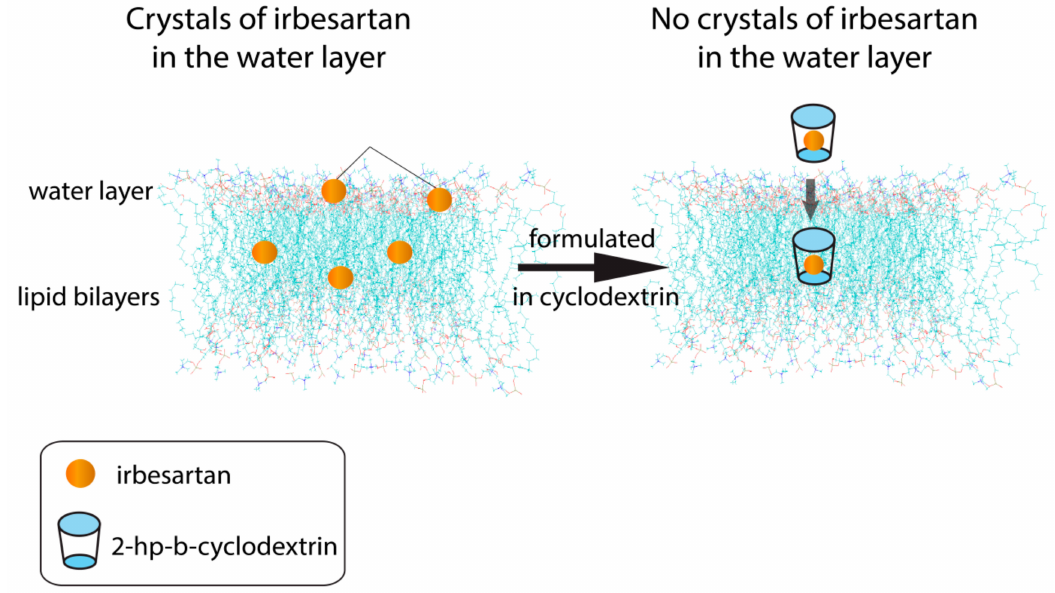
Figure 7. Irbesartan molecules crystallized into the lipid bilayers, although no crystals are observed when the drug is in complexation with